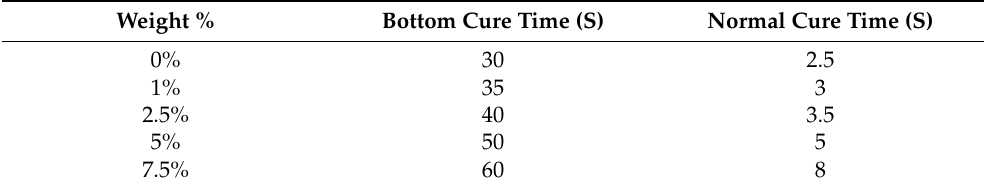
Table 1. Cure Settings for All Different Novel